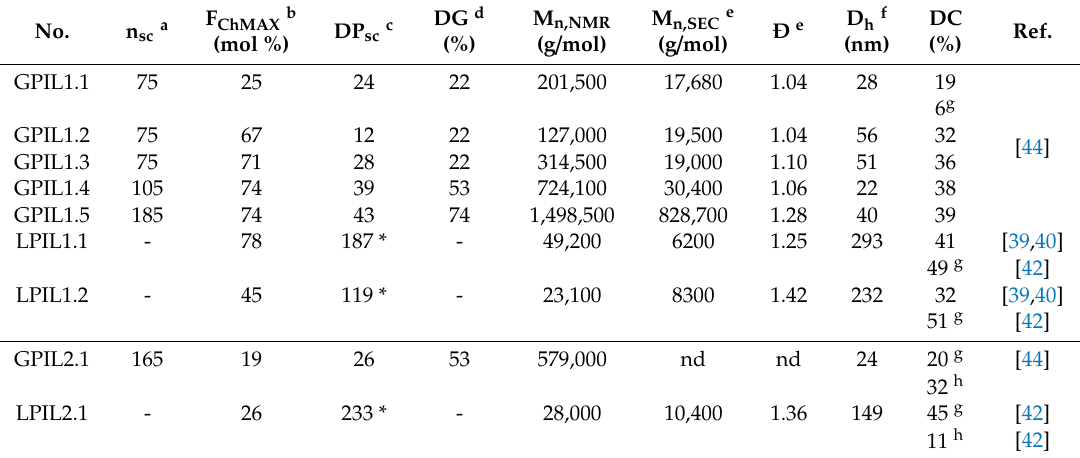
Table 1. Characterization of poly(ionic liquid)s GPIL vs. LPIL (DDS type